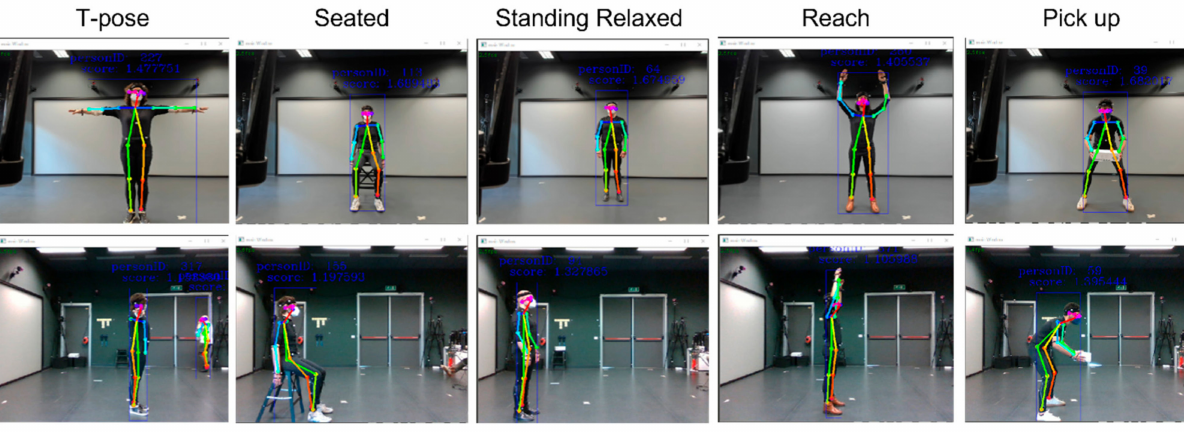
Figure 7. Body skeleton predicted by the